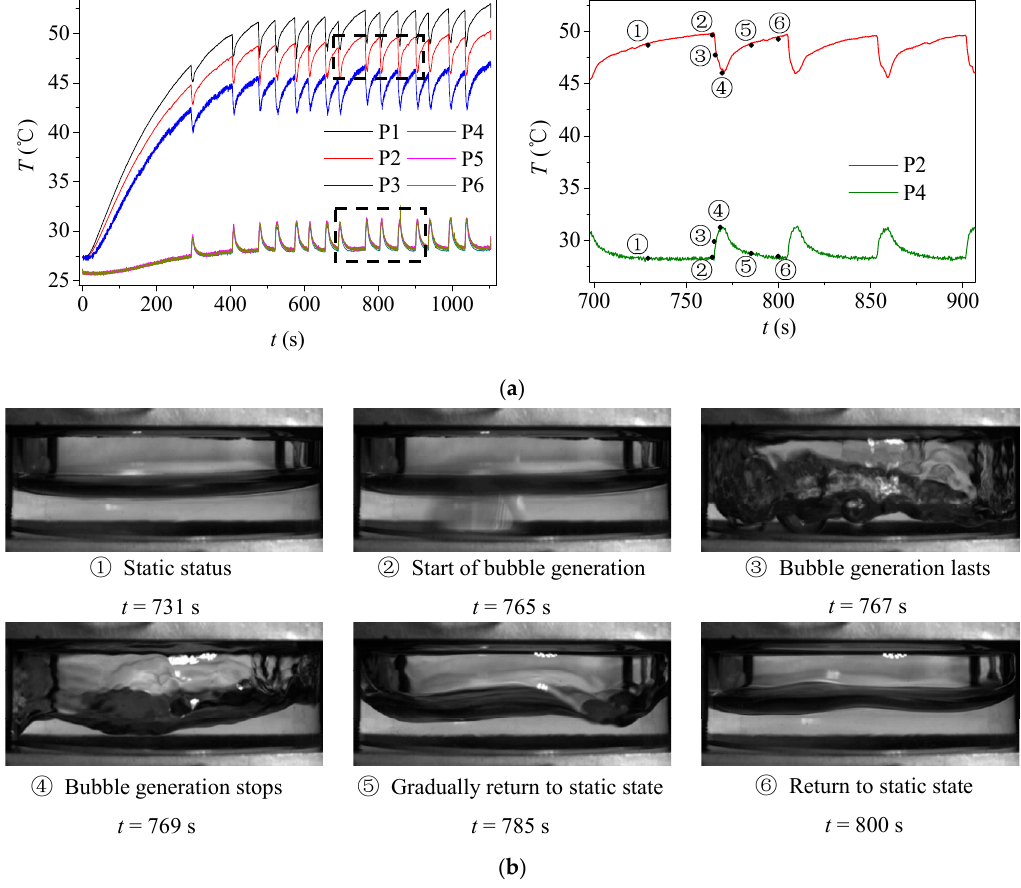
Figure 7. Continuous large-amplitude pulsation state ( φ = 47%, q = 6.4 W/cm 2 ): ( a ) dynamic variation of wall temperature pulsation; ( b ) gas – liquid two-phase behavior in one